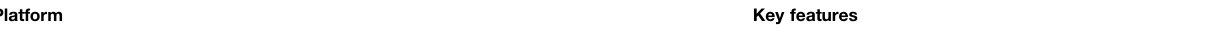
TABLE 1 | The six social VR platforms chosen for the